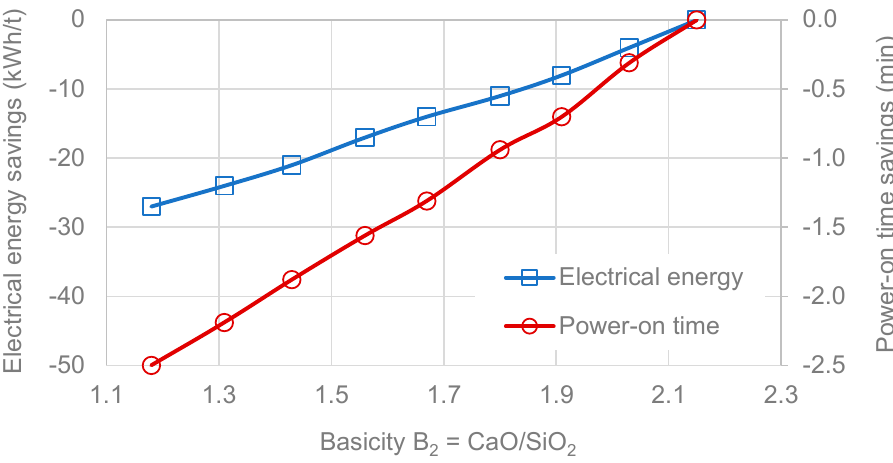
Figure 4. Calculated influence of lime and dololime input via slag basicity on power-in time and electrical energy demand of a 100% DRI-charged EAF model.